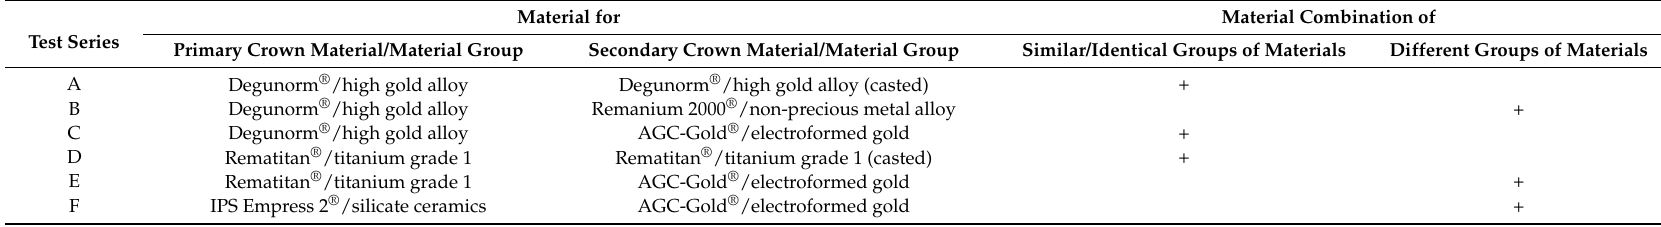
Table 1. Distribution of the materials to the primary and secondary crowns of the series of examinations. All metallic primary crowns were manufactured by casting.